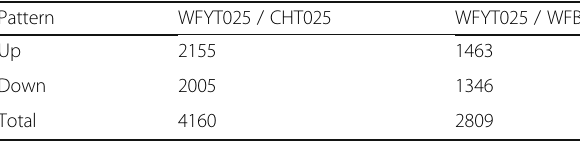
Table 3 Number and Classification of DG